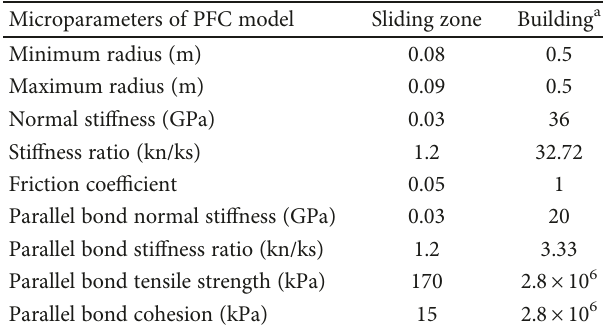
Table 3: Microparameters in the DEA models.